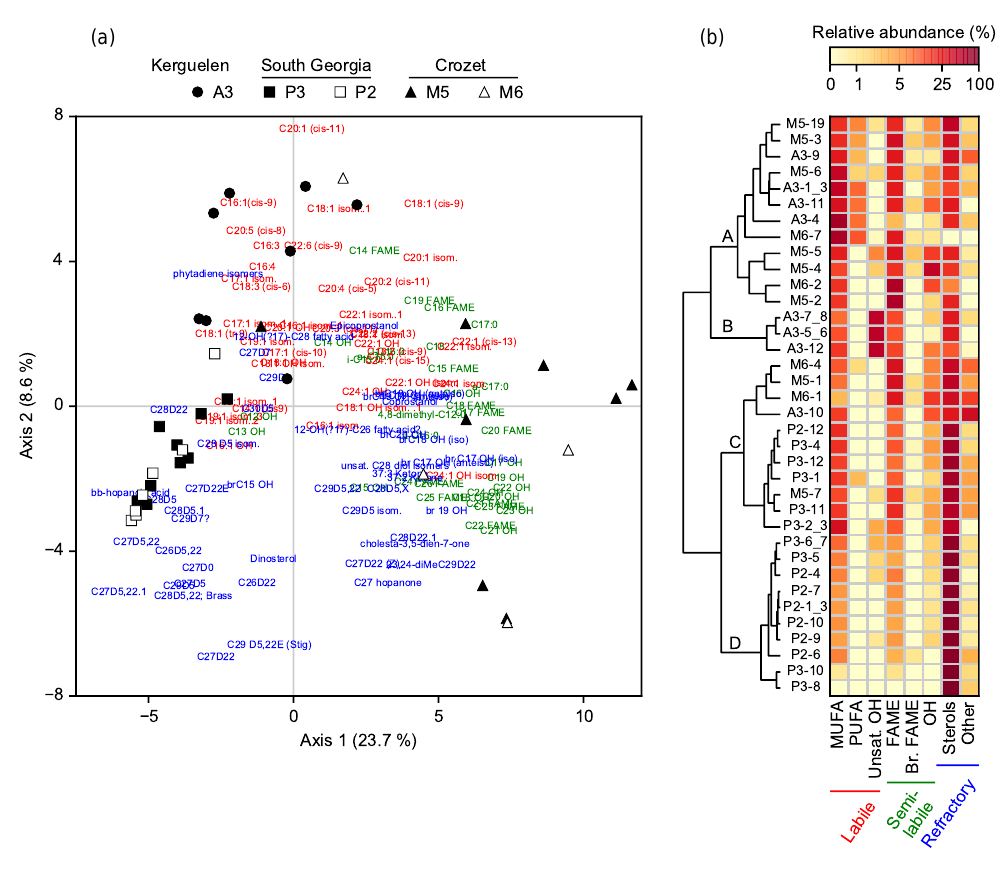
Figure 3. Association of lipid compounds with sediment trap samples. (a) Principal component analysis of the relative abundance of lipids ( n = 121). Black and white symbols represent respectively the naturally fertilized and the low productivity sites. (b) Clustering of the sediment trap samples based on the relative abundance of lipid classes (Euclidian distance, Ward aggregation criteria). Clusters A, B, C and D were defined based on the highest distance break after the first node. In (a) and (b) , colours show the lability of lipids according to Wolff et al.